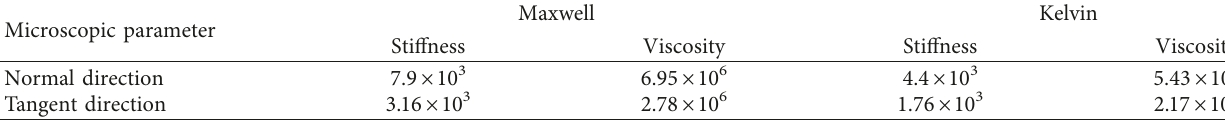
Table 7: Microscopic parameters of AC-13 Burger’s model.